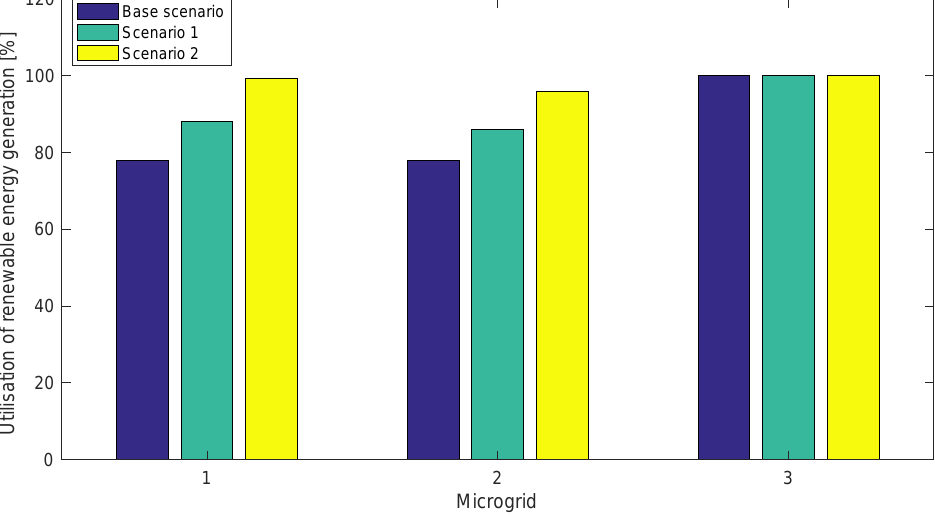
Figure 9. Percentages of renewable energy generation used by the GDCs. The remaining percentages are fed back into the